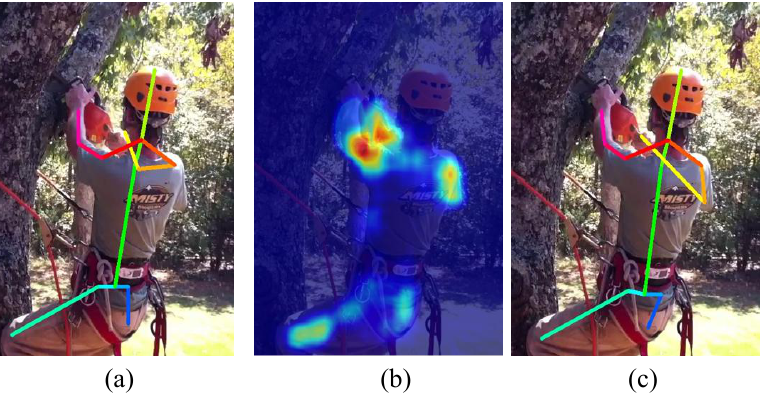
Figure 1. Illustration of human pose estimation in an occluded scene. ( a ) The pose estimation from HRNet [19]. ( b ) Visualization of bone information from our the bone prediction branch. ( c ) The pose estimation of our method. We observe that the visual-based HRNet fails to localize the right elbow, yet our approach delivers dependable pose estimation by exploiting bone